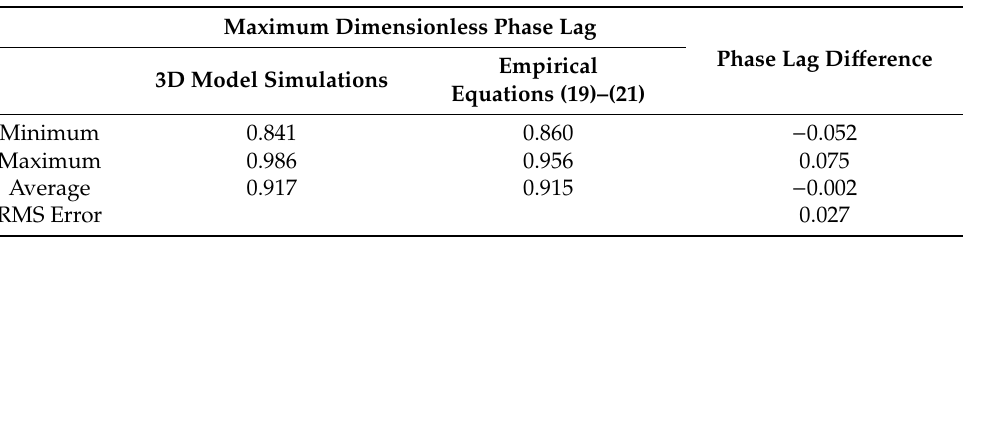
Table 6. Validation of empirical equations to predict phase lag to maximum shear stress for Simulation Sets 1–3 and 10–12. The di ff erences in phase lag (simulated by the 3D model and computed from Equations (19)–(21)) were computed for each channel and the minimum and maximum di ff erences are reported